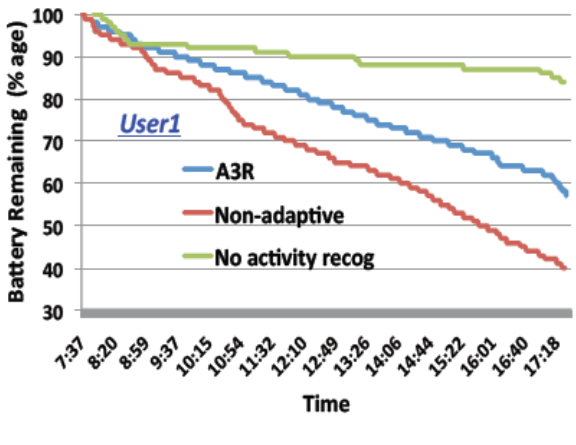
Figure 3 . Impact of confidence threshold on energy savings in A3R [6].